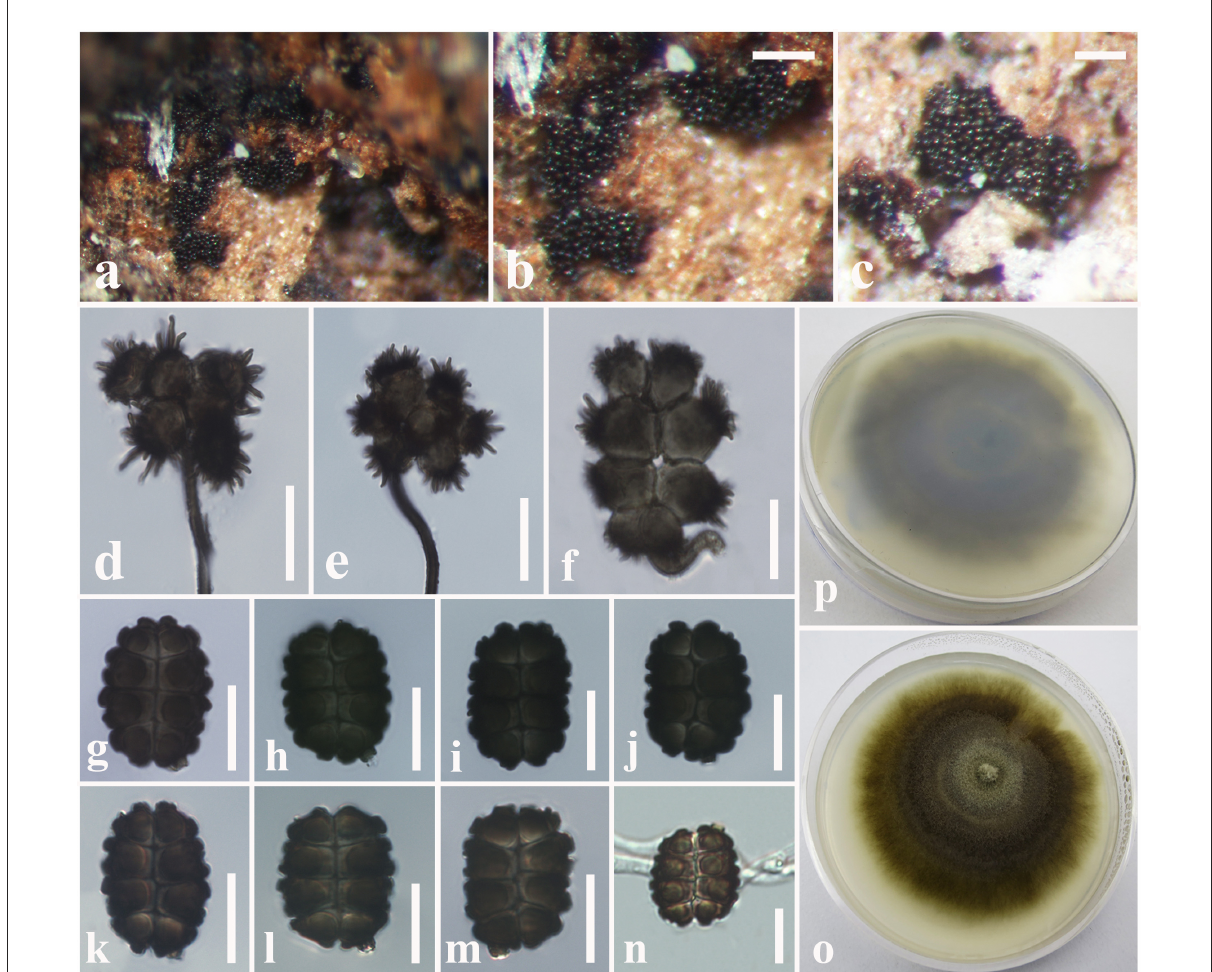
FIGURE10 Spegazzinia deightonii (MFLU 18-2564, new host record). (a–c) Fungal colonies on a dead stem of Hedychium coronarium . (d,e) α Conidia with conidiophores. (f) α Conidium with conidiogenous cell. (g–m) β Conidia. (n) A germinating β conidium. (o) Upper side of the culture. (p) Lower side of the culture. Scale bars: (b,c) = 20mm, (d–n) = 10 µ m.